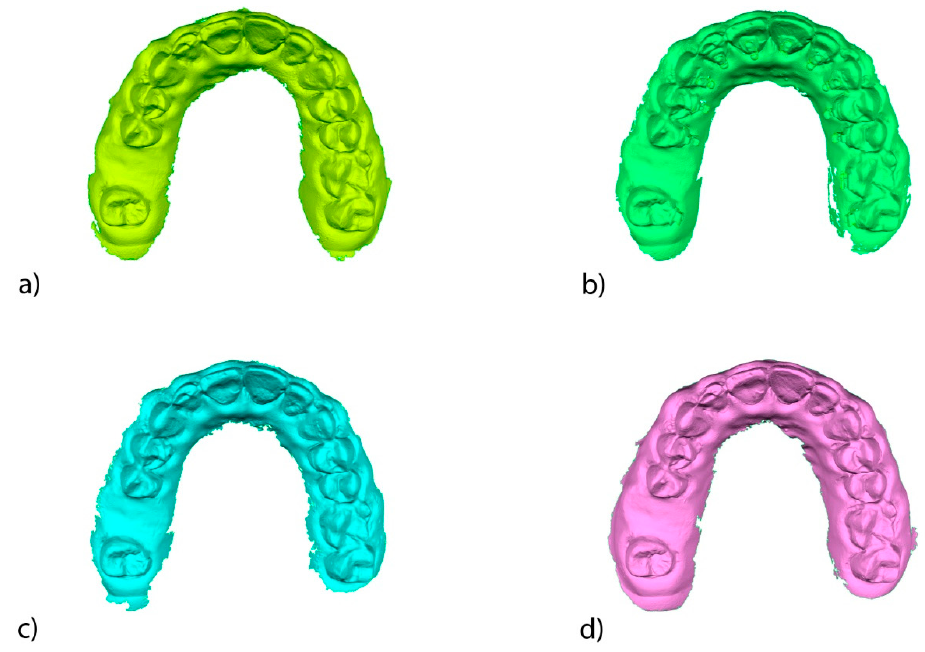
Figure 1. Occlusal perspective of the STL1 ( a ), STL2 ( b ), STL3 ( c ), and STL4 ( d ) digital